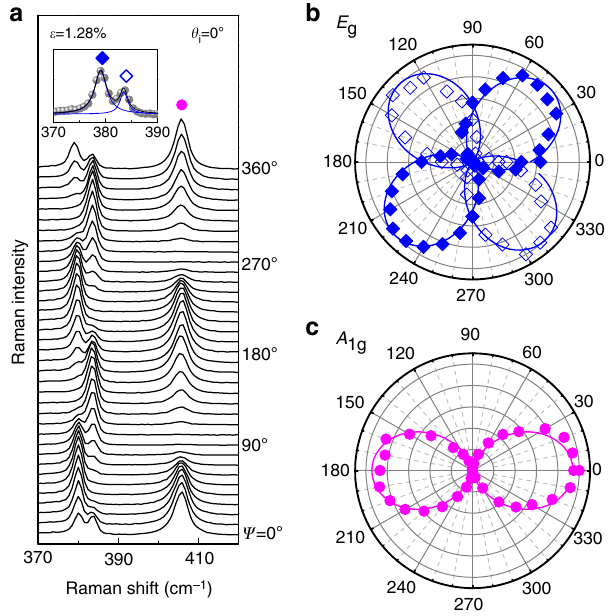
Fig. 4 Polarization dependence of intralayer Raman modes under strain. a Polarized Raman spectra of strained bilayer MoS 2 ( ε = 1.28%) for main intralayer modes. The incident polarization ( θ i ) is fi xed at 0° and the spectra are measured as a function of ψ de fi ned in Fig. 1a. Empty and fi lled diamond and circle symbols are de fi ned in Fig. 3. Normalized polar plots of b E g ( E g − and E g + ) and c A 1g